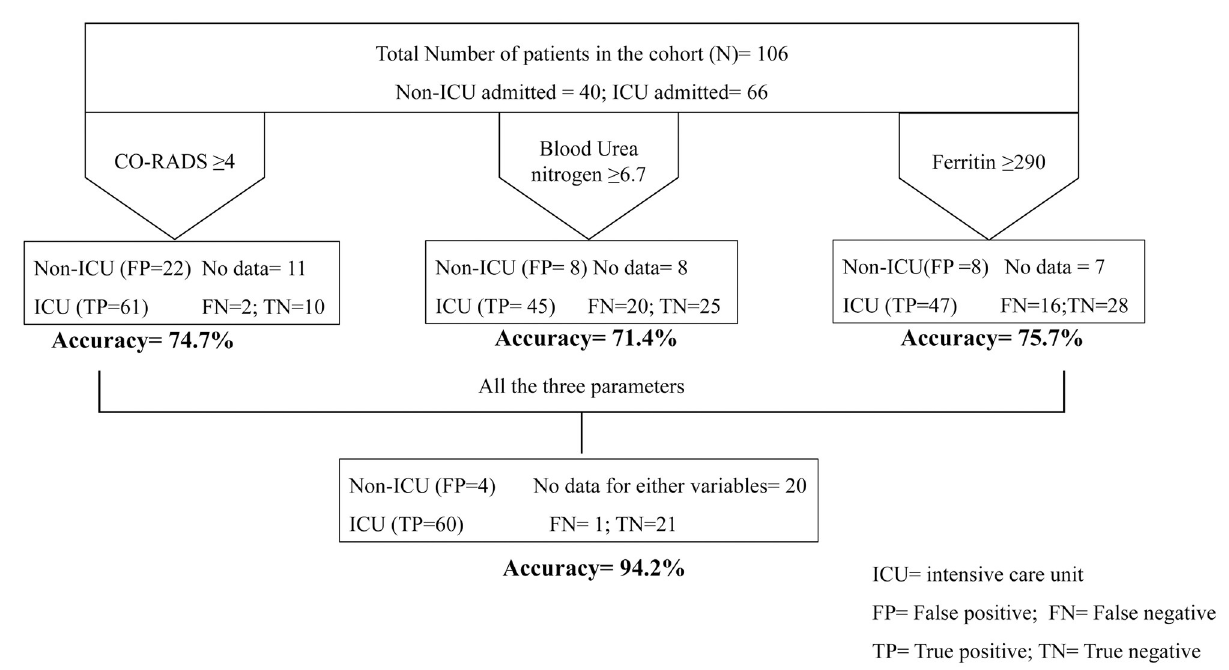
Fig 6. Schematic for the accuracy of the parameters to demarcate ICU admission among COVID-19 patients.